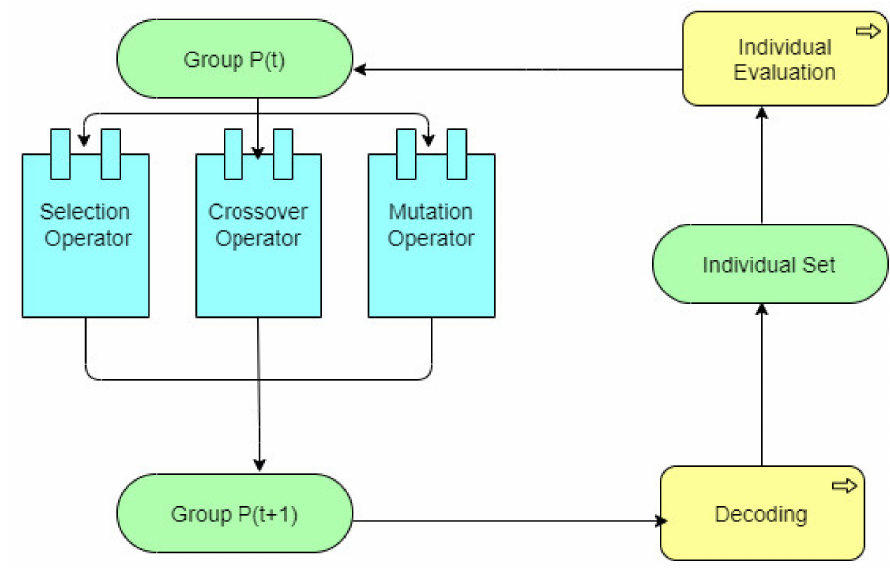
Figure 5. Genetic Algorithm flowchart.